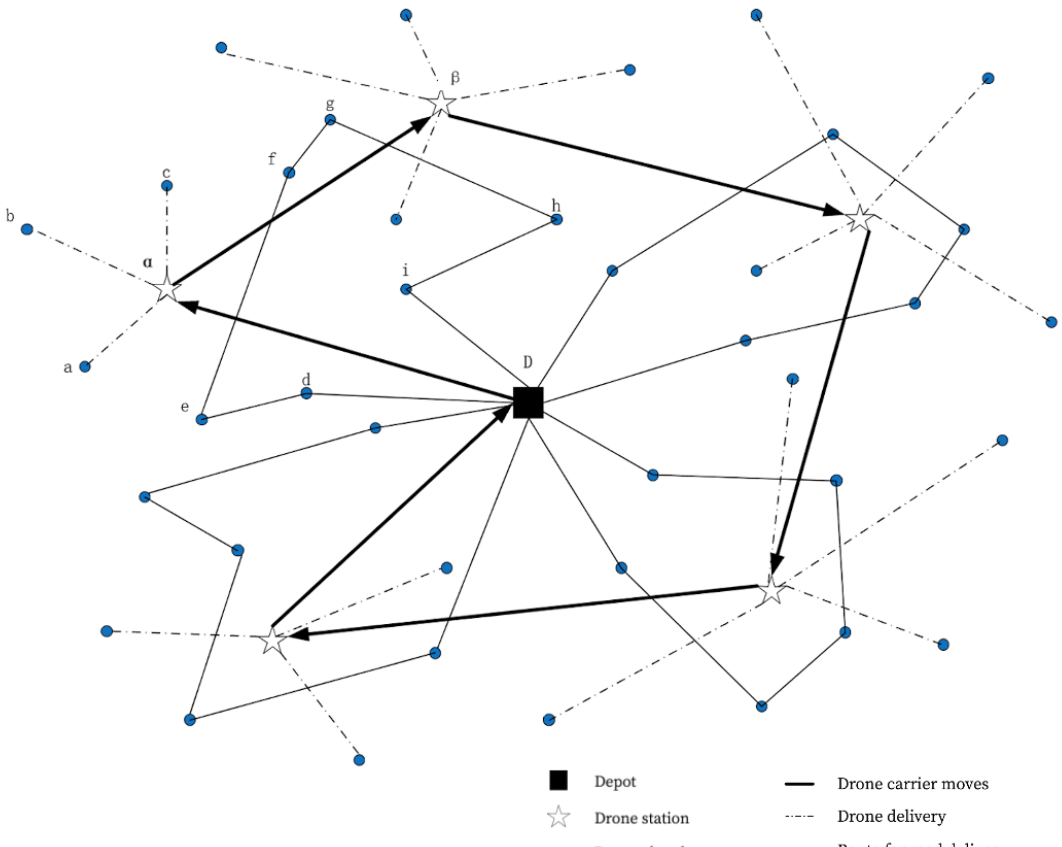
Figure 1. Illustrative example for the mTSP-LAP